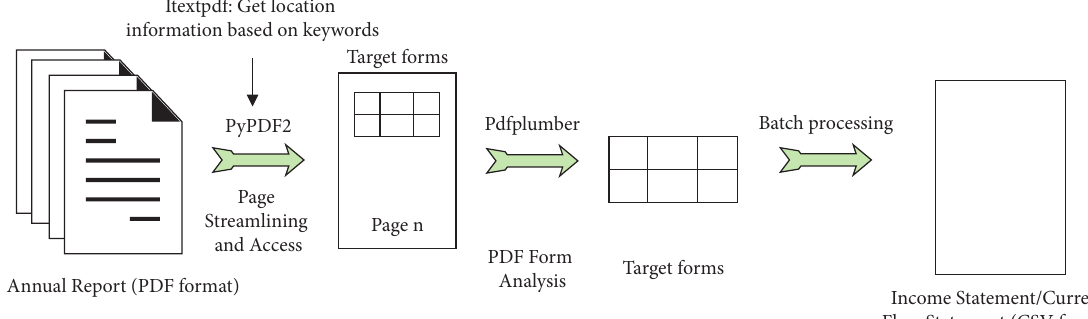
Figure 1: Data extraction